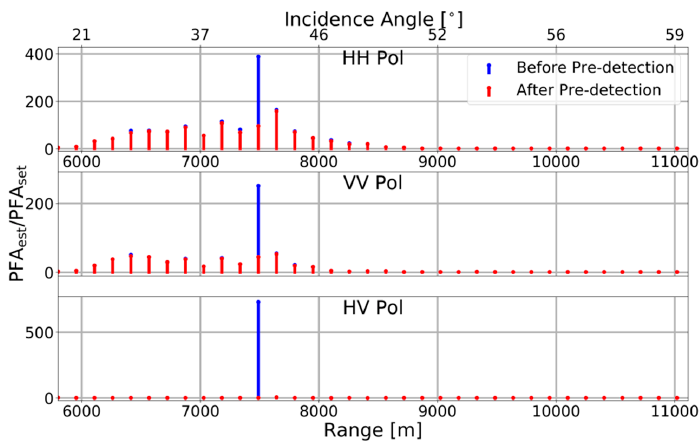
Figure 12. Ratio of the false alarm rates over range for X-band HH (top), VV (middle) and HV (bottom) polarization before (blue) and after pre-detection and target cancellation (red). Note that a ship target is present at around 42 ° incidence angle.